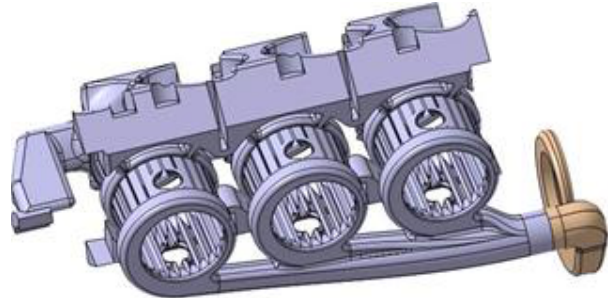
Fig. 1. Channels inside an OPE aircraft engine block with the flow along the axis of the cylinders